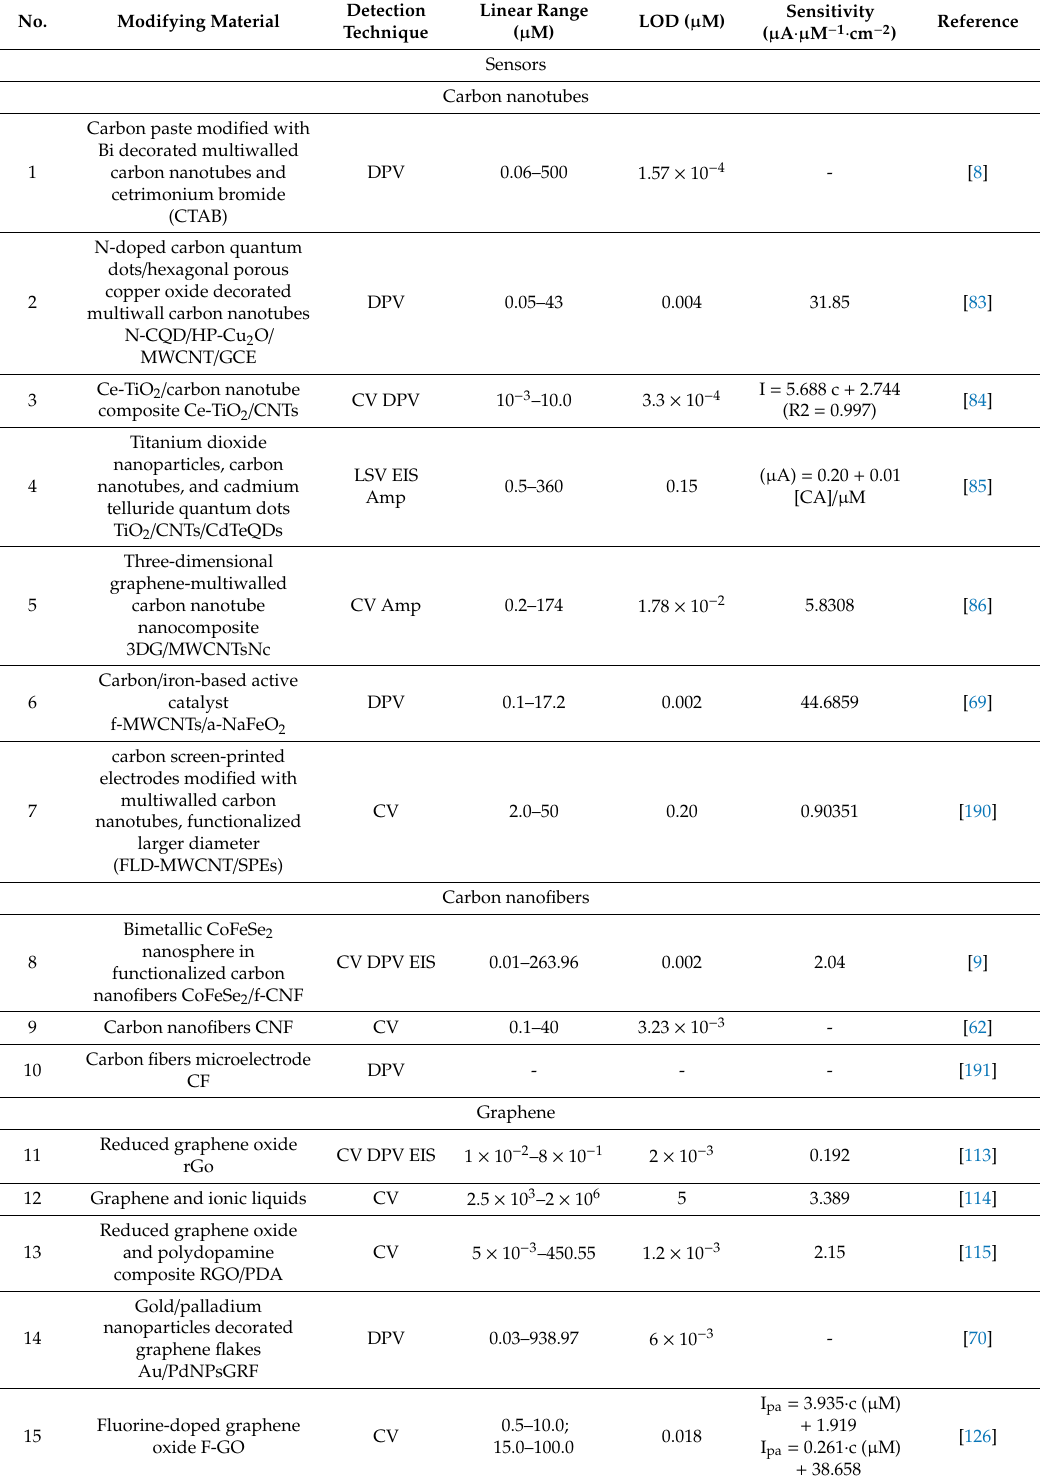
Table 1. Electrochemical sensors and biosensors used for CA